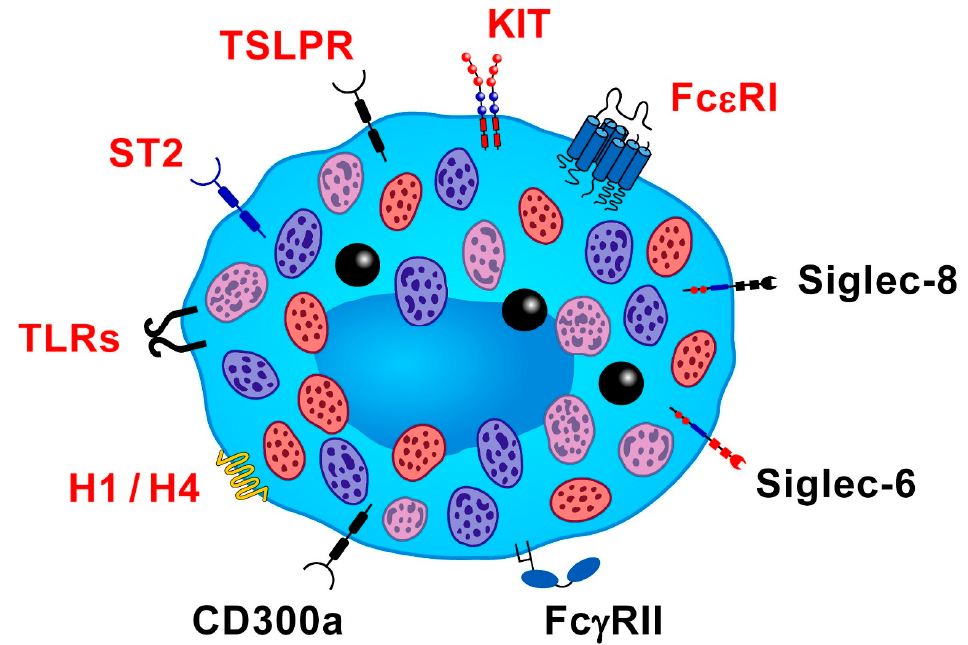
Figure 1. Schematic representation of activating (in red) and inhibitory (in black) receptors on human lung mast cells. A complete ( αβγ 2), high-affinity receptor for IgE (Fc ε RI) is expressed by human mast cells and basophils [31]. Antigens, superantigens, and anti-IgE lead to mast cell activation and mediator release through the aggregation of Fc ε RI bound to IgE [31–33]. Mast cells play a role in allergic disorders by releasing preformed (e.g., histamine, tryptase) and de novo synthesized mediators (e.g., cysteinyl leukotriene C 4 (LTC 4 ), prostaglandin D 2 (PGD 2 )) and several cytokines and chemokines [3,19]. SCF, which activates the KIT receptor (CD117), highly expressed by mast cells throughout their development, is the most important factor regulating these cells [34,35]. SCF is released by a plethora of cells, including fibroblasts, endothelial cells, and mast cells themselves [36,37]. Thymic stromal lymphopoietin (TSLP) is expressed by airway epithelial cells [38], keratinocytes [39], immune and structural cells [40] and acts as an alarmin. TSLP activates the heterodimeric receptor comprising IL-7R α and TSLP receptor (TSLPR) on mast cells and other immune cells [41–43]. TSLPR mRNA, but not IL-7R α mRNA, is expressed by human mast cells [42,44]. TSLP, under certain experimental conditions [42], can induce the release of chemokines and cytokines from mast cells [45]. IL-33 is released by damaged epithelial and endothelial cells [46,47] and activates mast cells [48,49]. IL-33 engages the heterodimeric receptor, ST2-IL-1RAcP, on human mast cells [50–52] and induces cytokine [50,53–56] and chemokine release [57]. IL-33 and